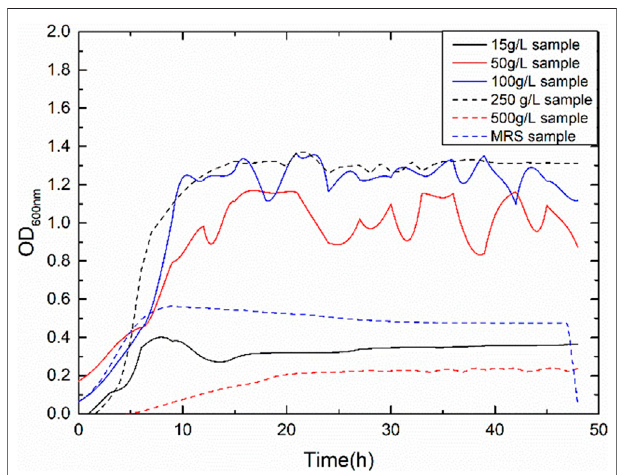
FIGURE 3 | Variation of pH with sucrose concentration.